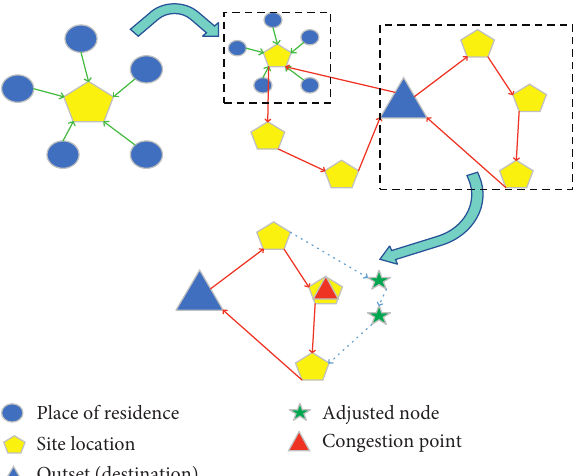
Figure 4: Changes in vehicle routes.